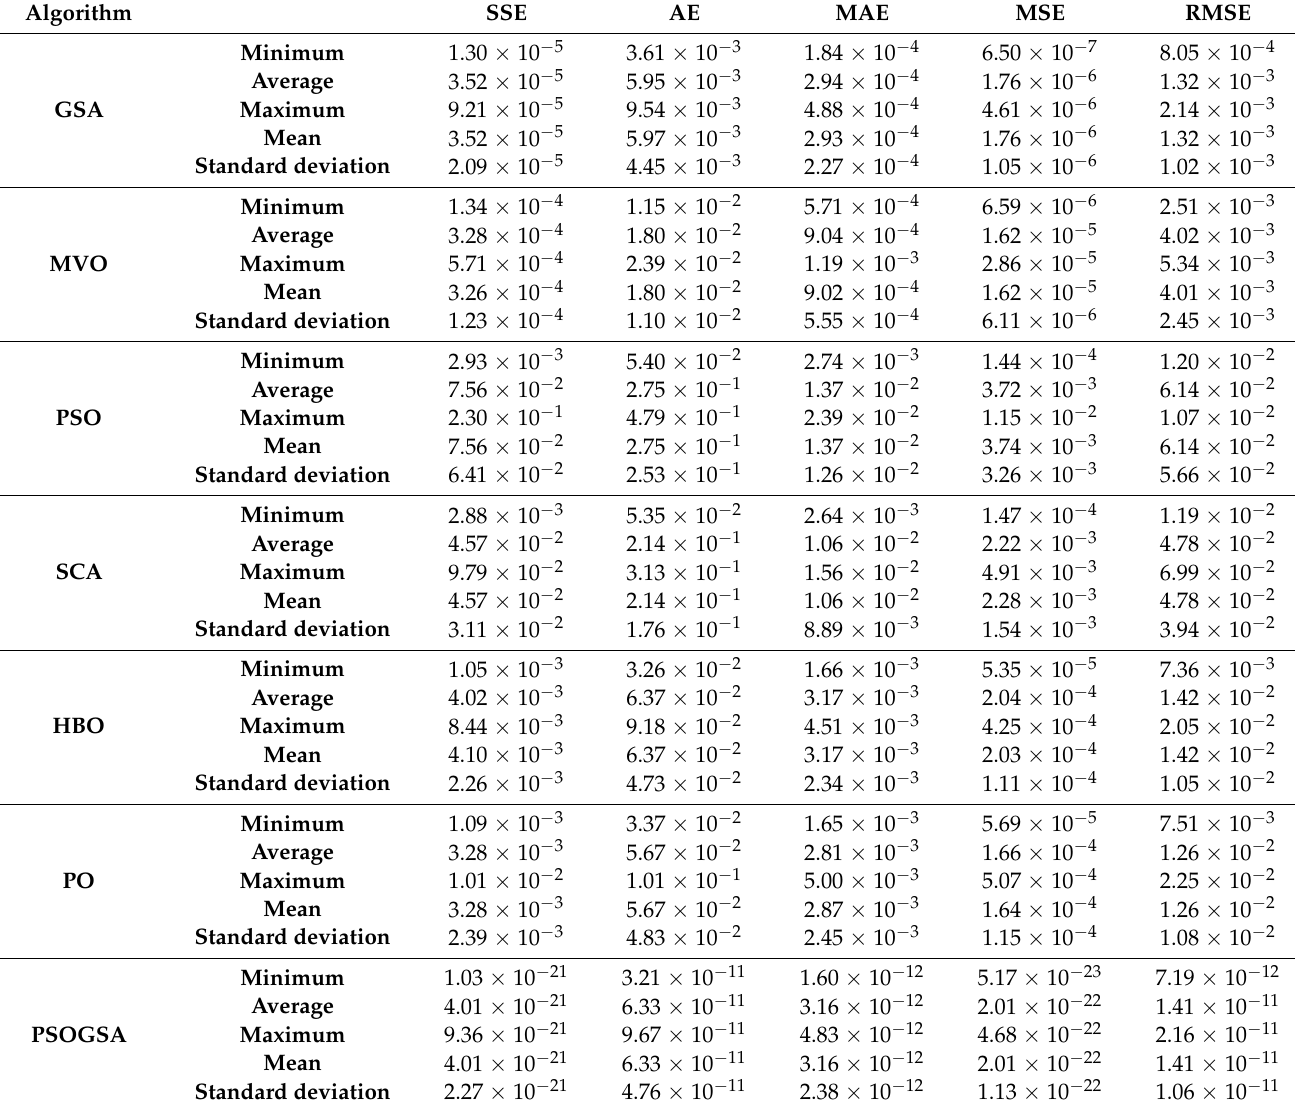
Table 7. The MDDM calculation error, mean and standard deviation for the monocrystalline PV cell.